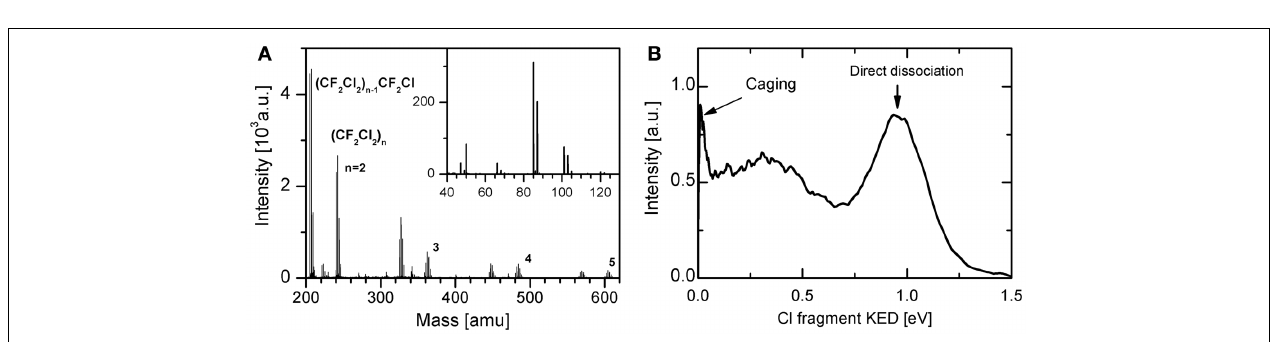
FIGURE 2 | Examples of experimental data measured for HCl pickup on Ar n (A,B), and HCl on (H 2 O) n (C,D): mass spectra (A,C) and H-fragment KED after the photodissociation with